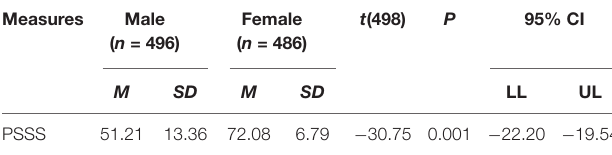
TABLE 4 | Mean differences across gender on